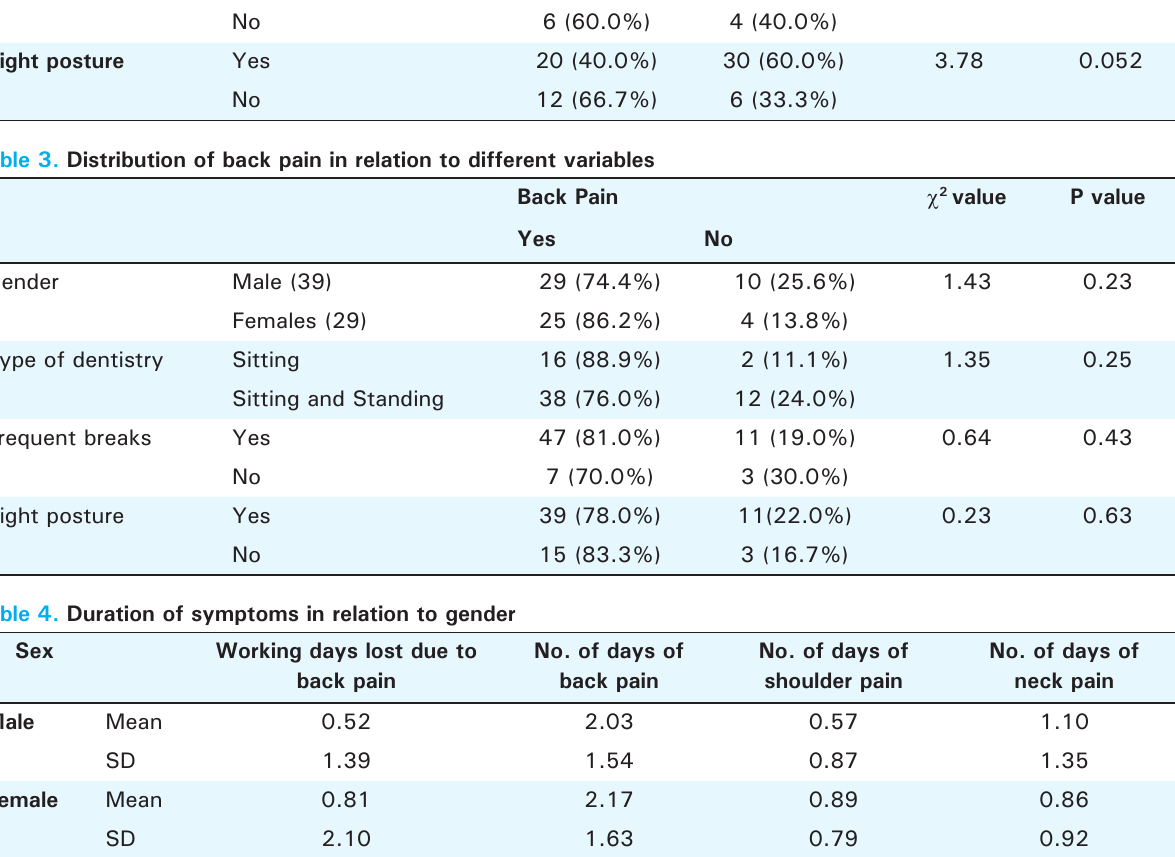
gender type of dentistry Frequent breaks right posture